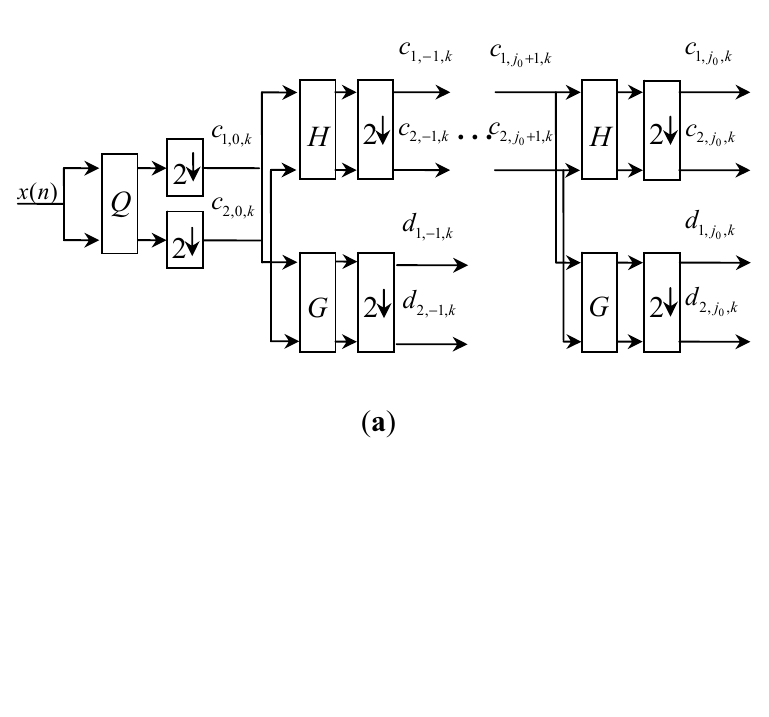
Figure 2. ( a ) Decomposition ( r = 2) of MWT. ( b ) Reconstruction ( r = 2) of